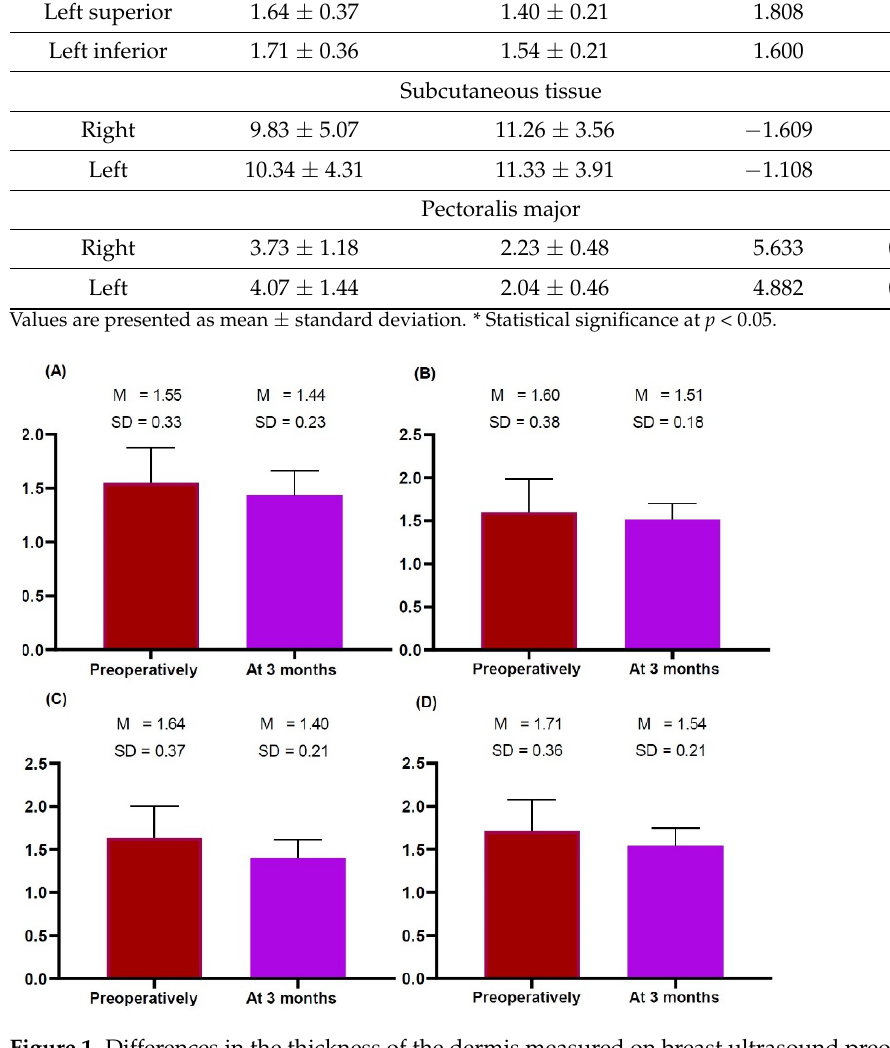
Figure 1. Differences in the thickness of the dermis measured on breast ultrasound preoperatively and 3 months postoperatively. Preoperatively and 3 months postoperatively, the thickness of skin was measured ( A ) in the right superior, ( B ) the right inferior, ( C ) the left superior and ( D ) the left inferior region of the breast. This showed no significant differences in the thickness of skin between the preoperative and 3-months postoperative measurements ( p > 0.05). Note: The y -axis indicates